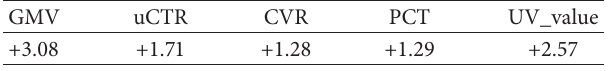
Table 4: The improvements (%) of online test.